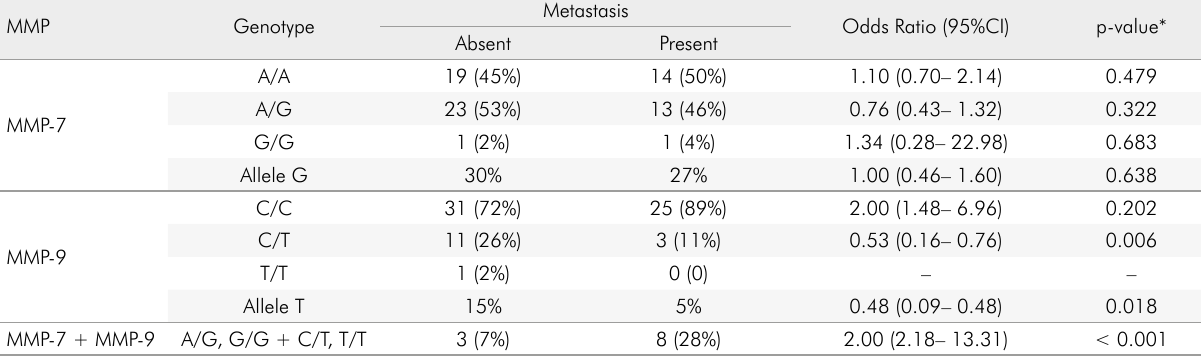
Table 4. Distribution of MMP-7 and -9 genotypes in OTSCC and control according to nodal metastasis.